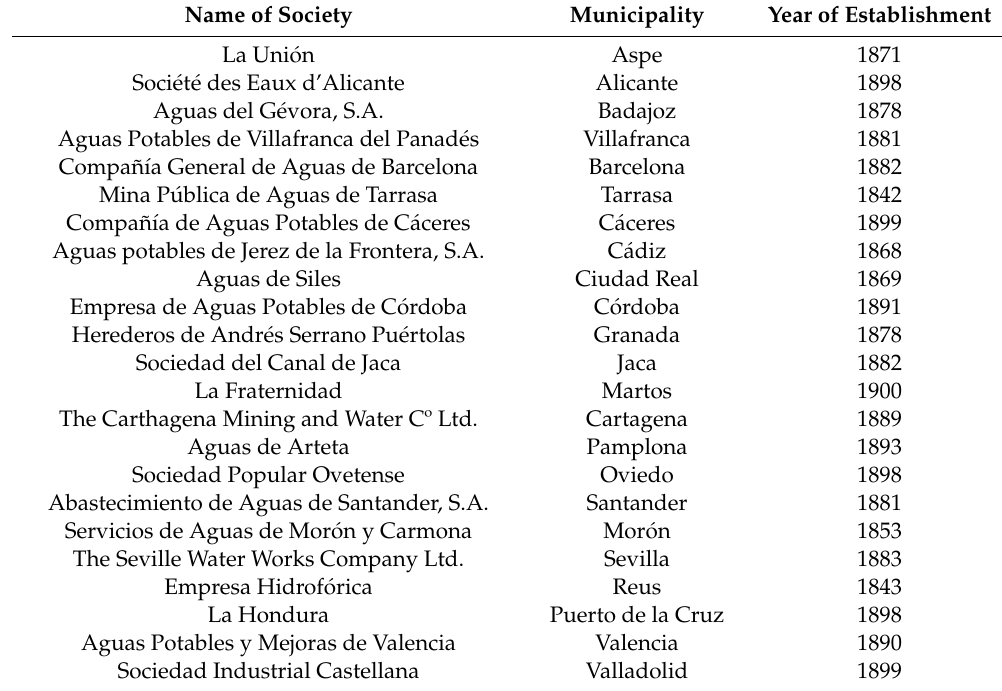
Table 8. Companies established in the 19th century and in business for over 20